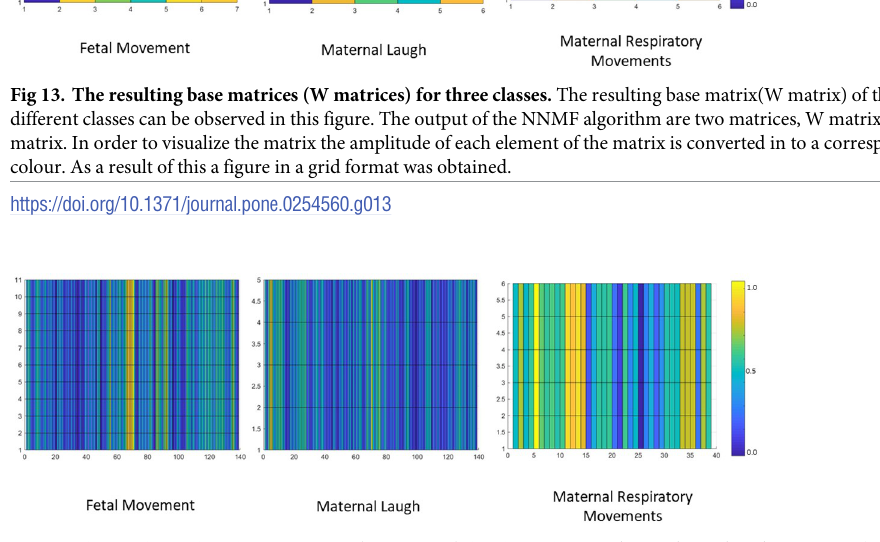
Fig 14. The resulting abundance matrices (H matrices) for three classes. The resulting abundance matrix(H matrix) of three different classes can be observed in this figure. Similar to what is done with the W matrix in order to visualize the matrix the amplitude of each element of the matrix is converted in to a corresponding colour. As a result of this a figure in a grid format was obtained.